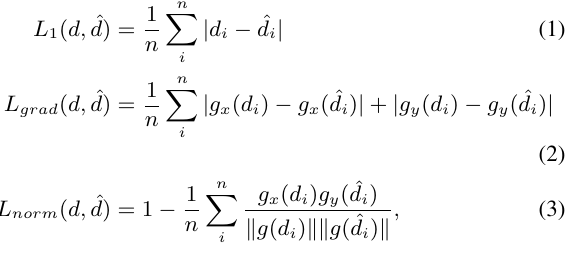
Figure 2. RGB point cloud visualizations of the original TLS data and the de-noised point cloud which was further used as ground truth. As illustrated, the filtered data contains mainly tree stem points and ground points. The second example is more challenging due to the abundant vegetation occluding a major part of the tree stems. Hence the noticeable tree crown areas present in the filtered image. times by a small angle along the longitude. The latter produced new 360 ◦ images as rotated versions of the initial 360 ◦